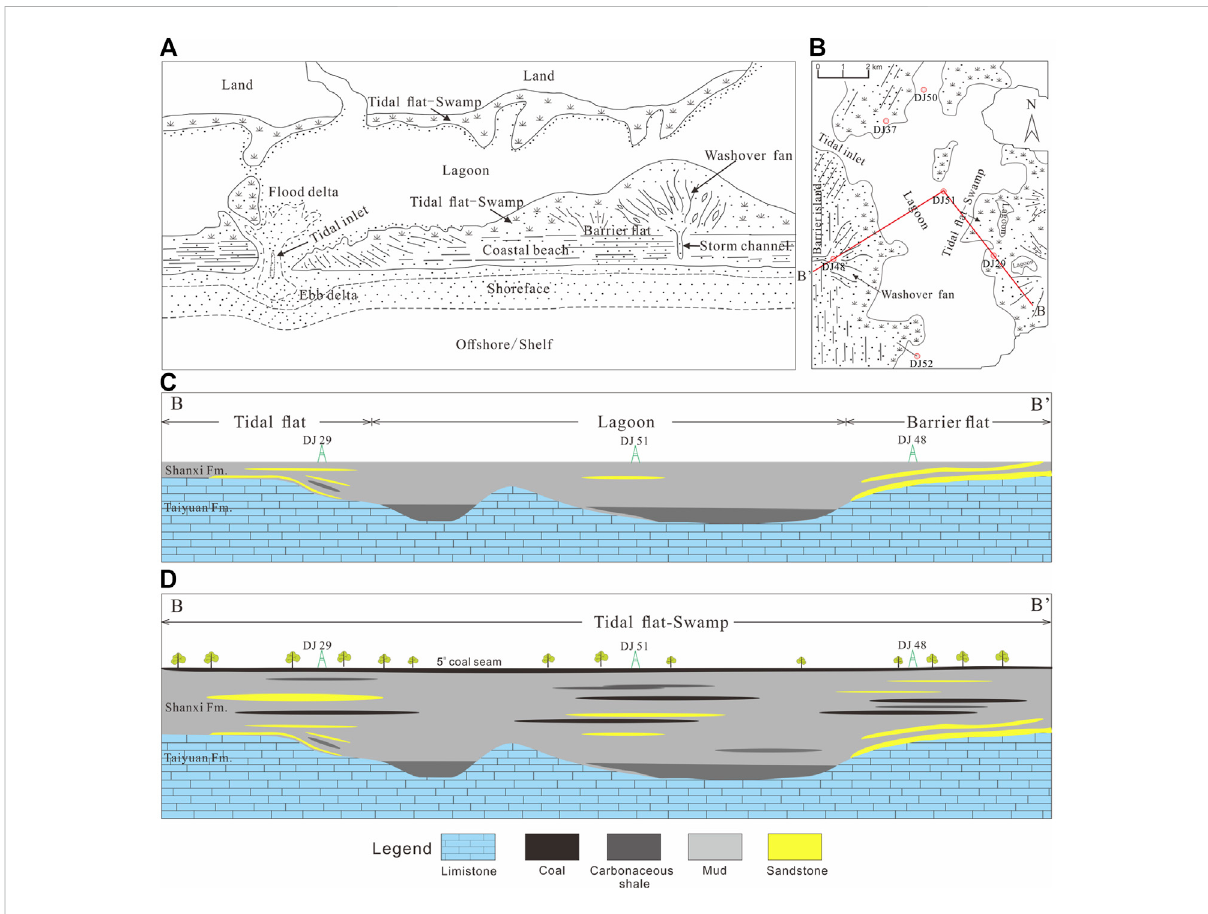
FIGURE 14 Comprehensive comparison of the barrier island-lagoon sedimentary model in the Shan-2 Lower Sub-member in the eastern Ordos Basin. (A) Plane of the barrier coast sedimentary model (according to P.A. Schole and D. Spearing, 1982; as quoted and modi fi ed from Sun and Li, 1986). (B) Planeofthebarrierisland-lagoonsedimentarymodelinthestudyarea.Pro fi lesofthebarrierisland-lagoonsedimentarymodelduringtheearlystage (C) and the later stage (D) of the Shan-2 Lower